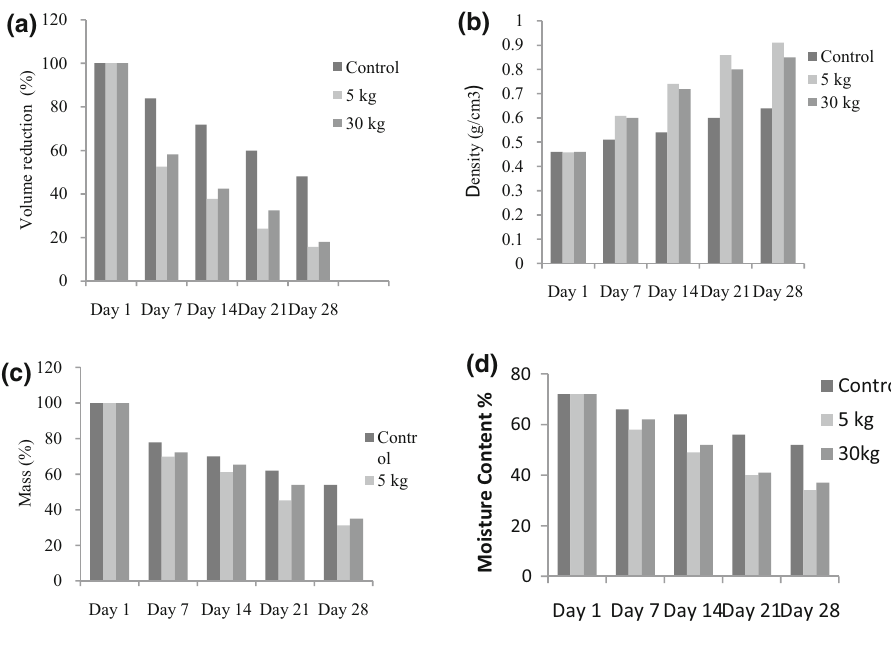
Table 7 Comparison of temperature difference in the 5 kg and 30 kg waste